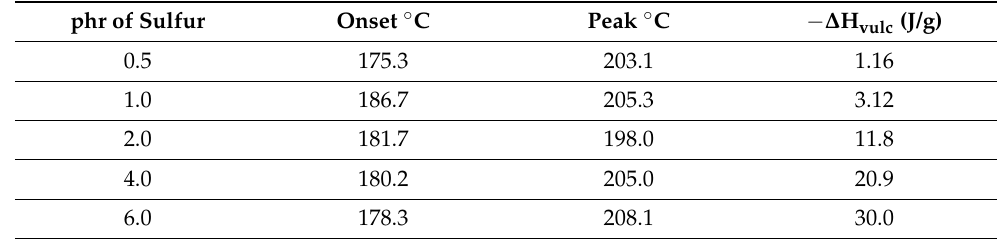
Table 3. Vulcanization Enthalpy of NR-rubber compounds of reported in Table 1 heating rate 20 ◦ C/min in sealed medium pressure stainless steel